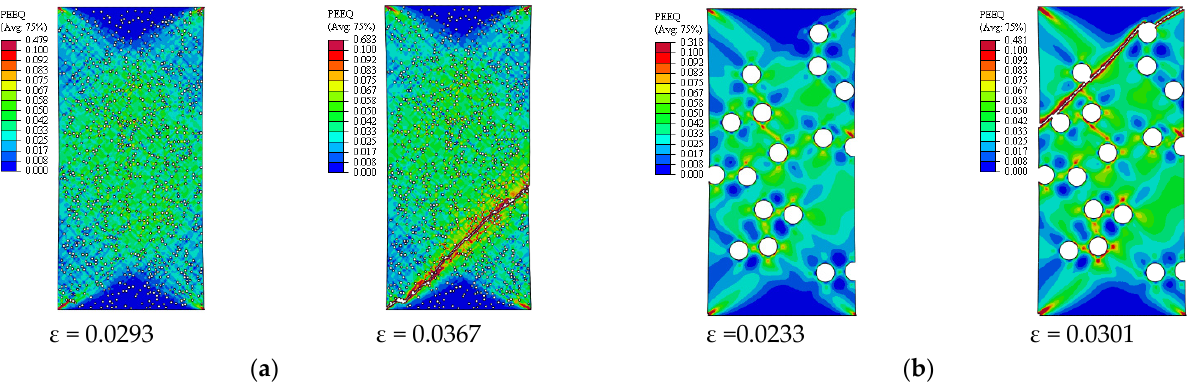
ε = 0.0293 Figure 18. Effective plastic strain in the matrix of A359/SiC composite (10% VF): ( a ) PS = 2 µm; ( b ) PS = 15 µm.